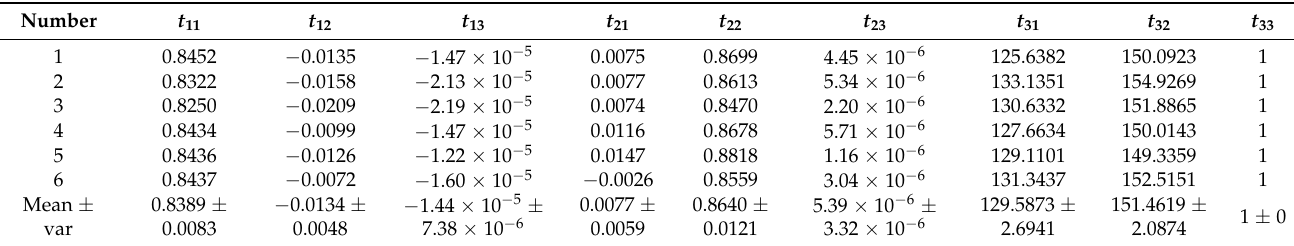
Table 2. Elements of transformation matrix for six independent